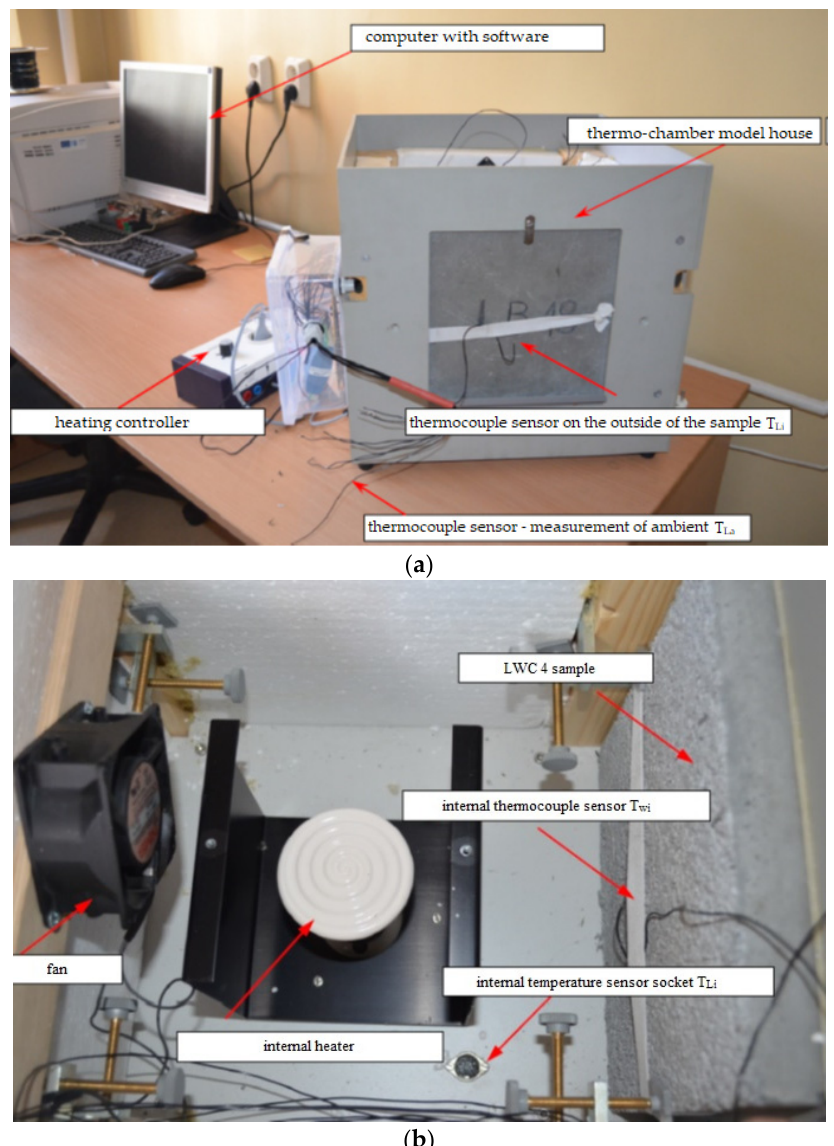
Figure 2. Model house construction: ( a ) outer elements; ( b ) inner elements. Thermal conductivity coefficient λ was calculated by means of inner and outer model house temperature measurement, and by measurement of the inner and outer wall temper- ature of the tested specimen. The temperature was measured each 10 min since establishing balance state on the sides of the specimen. Thermal balance on the walls of the specimen was achieved after 5–6 h, but to receive more detailed test results, the temperature was being measured for 8 h each 10 min. Measurement results were recorded T Li , T wi , T wa , and T La . Figure 3 shows the scheme of heat transfer through the